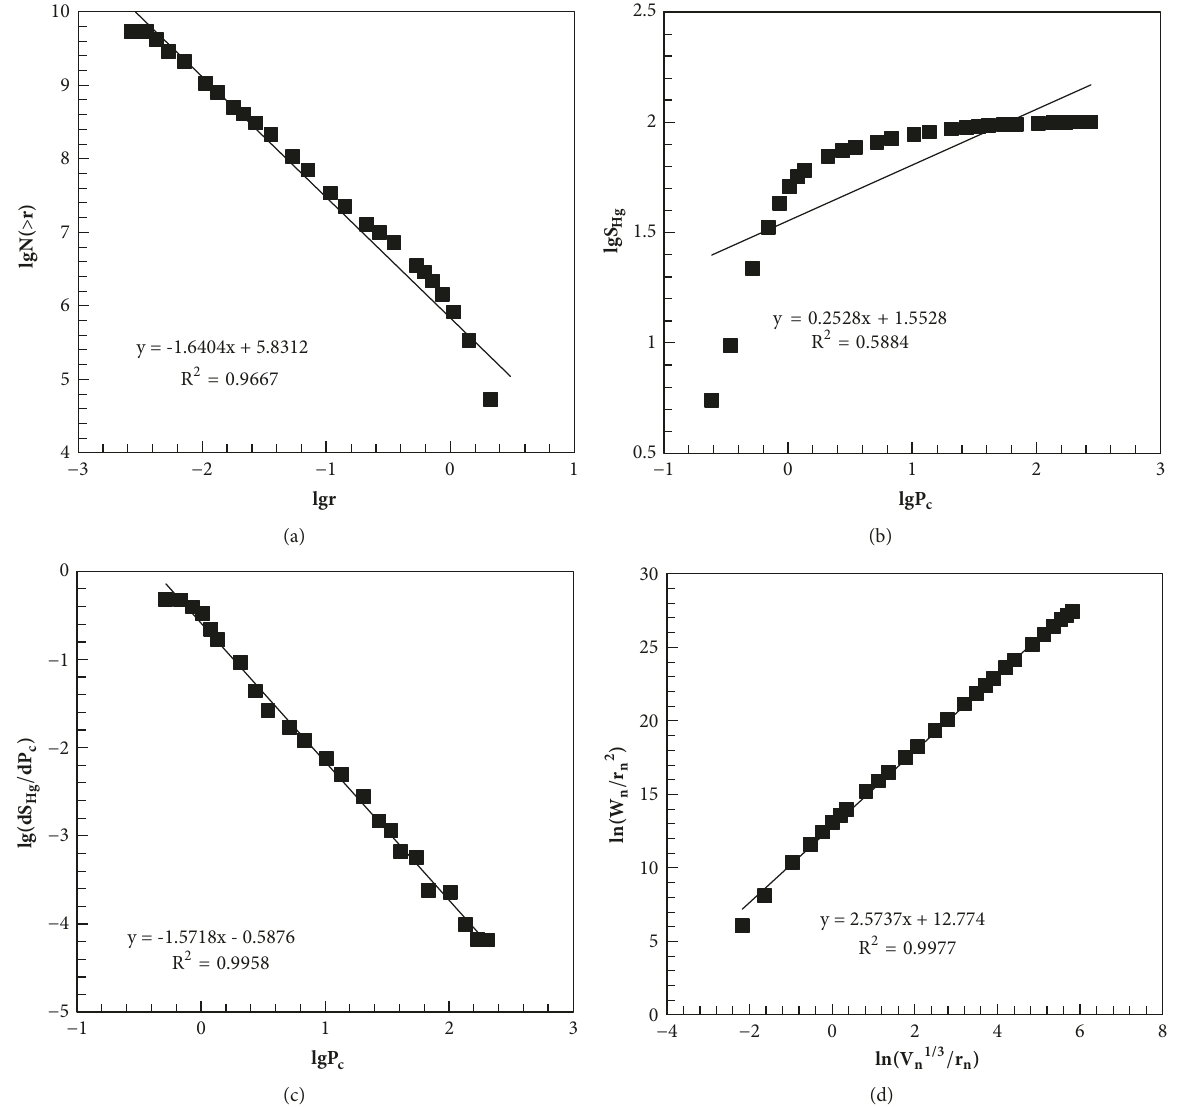
Figure 3: Fractal dimension calculation from the slope of straight line in log-log plots with different methods ((a) method I-2D capillary tube model; (b) method II-3D capillary tube model; (c) method III-geometry model; (d) method IV-thermodynamics